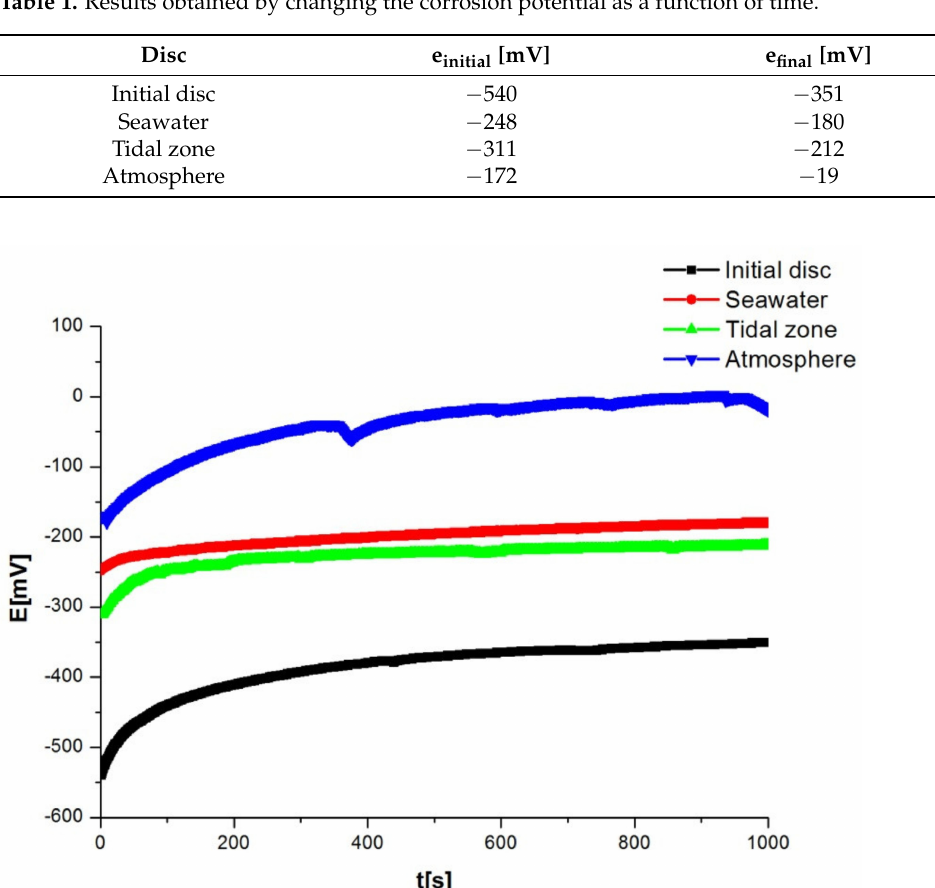
Table 1. Results obtained by changing the corrosion potential as a function of time.